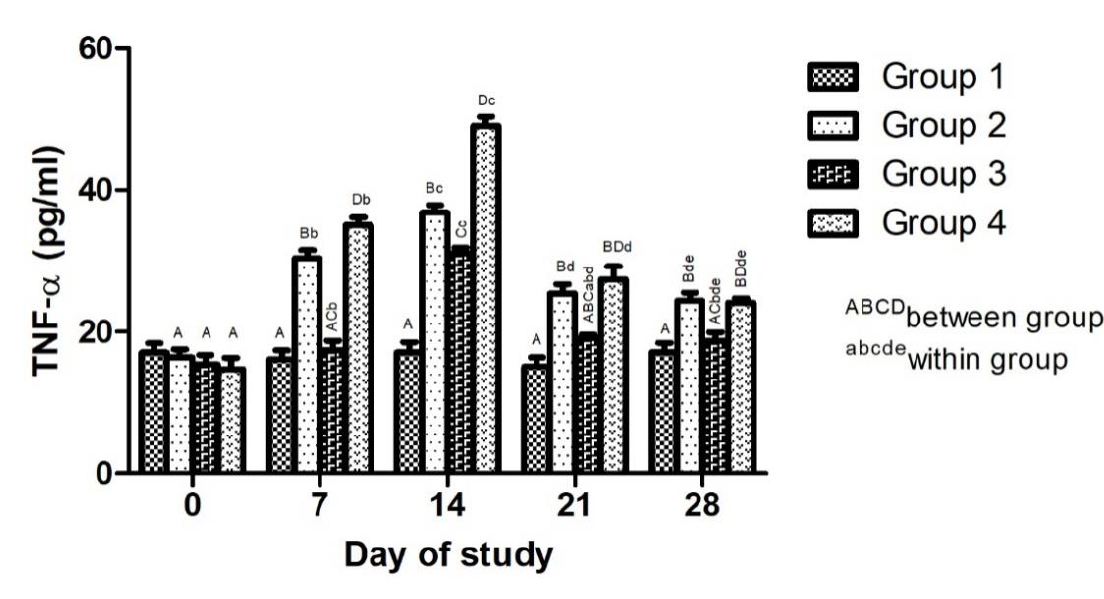
Figure 2. Effect of adjuvanted, sonicated antigens on levels of tumor necrosis factor alpha (TNF- α ) (pg/mL) in rabbits.